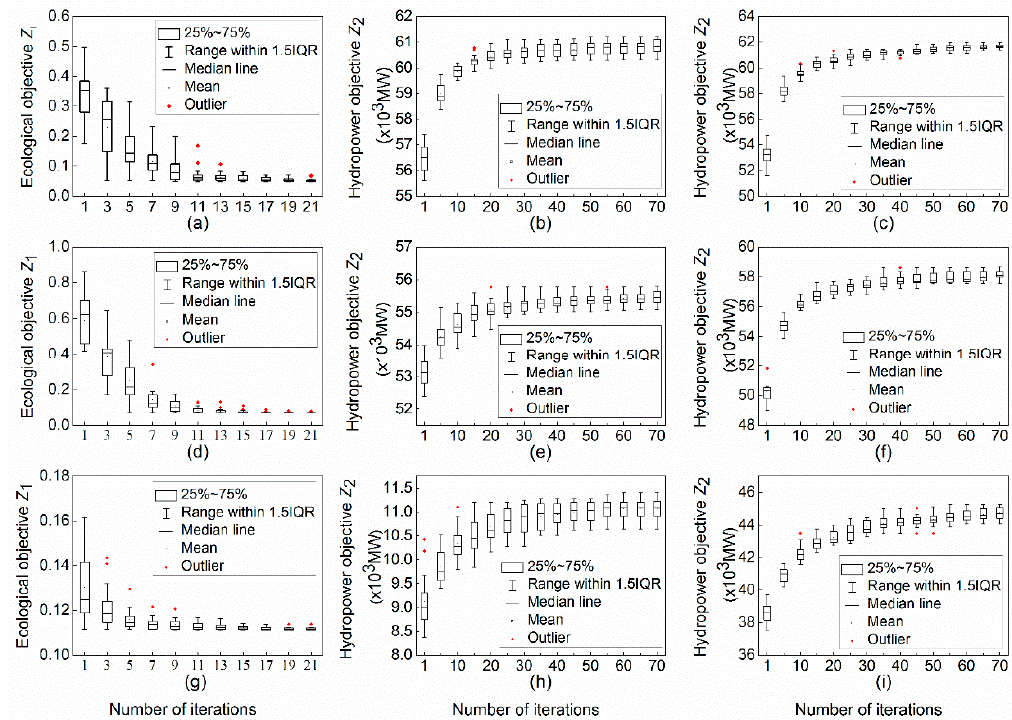
Figure 4. Convergence procedures of di ff erent models with 20 trials in di ff erent hydrological representative years, where ( a – c ) stands for model A, model B, and model C in the wet year (2011), respectively; ( d – f ) stands for model A, model B, and model C in the normal year (2014), respectively; ( g – i ) stands for model A, model B, and model C in the dry year (2015), respectively.